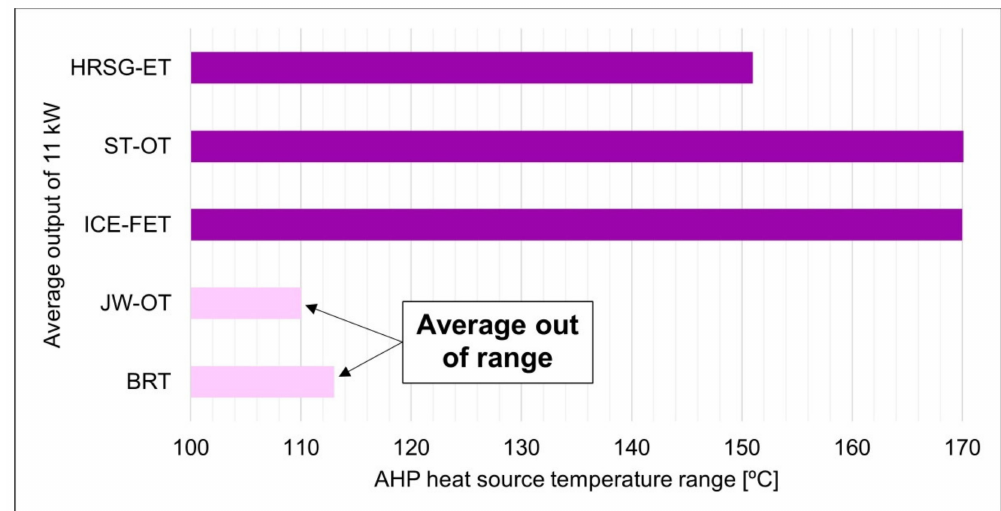
Figure 5. Potential waste heat recovery technologies suitable for feeding Absorption Heat Pump systems.